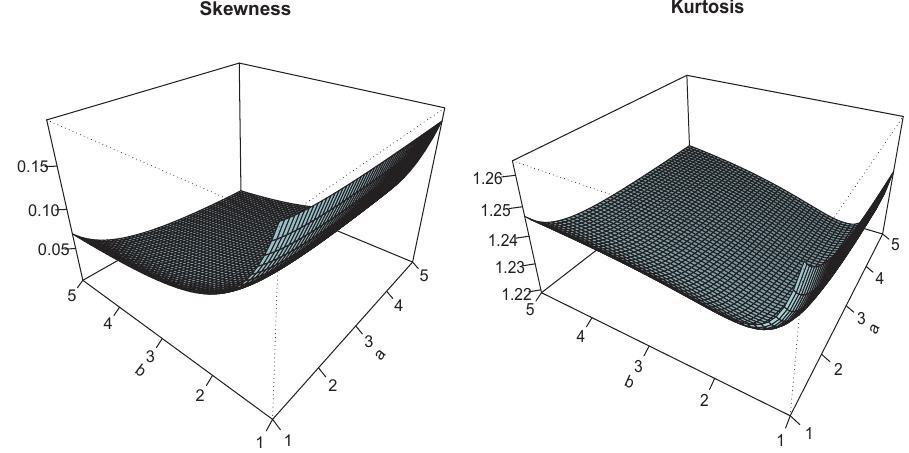
Figure 6. Plots of γ ∗